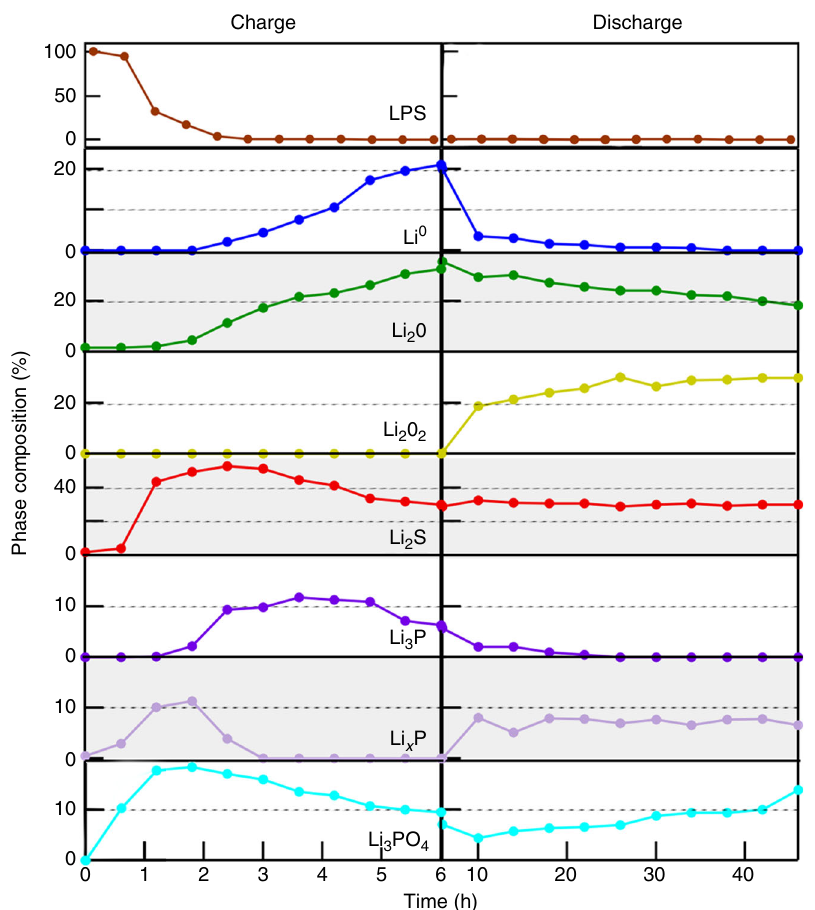
Fig. 4 Evolution of SEI phase composition. Phase composition as a function of time for both the charge and the discharge half-cycles. Data from this graph clearly show the redox activity of the Li 2 O and Li 3 P components of the SEI during the discharge